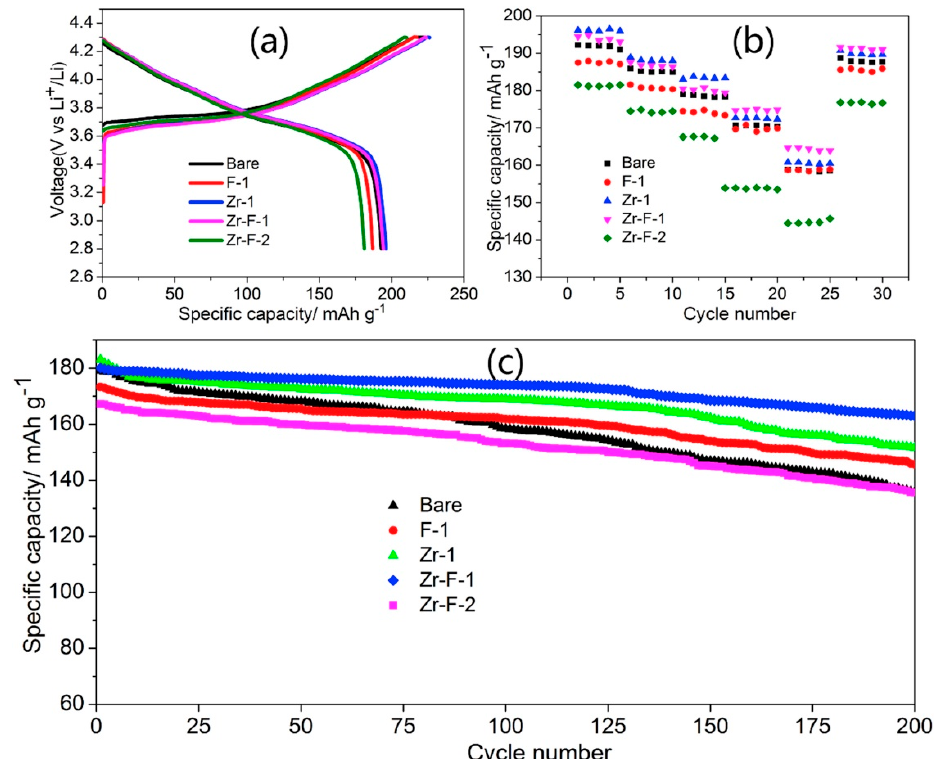
Figure 4. Electrochemical properties of Li(Ni 0.80 Co 0.15 Al 0.05 ) 1 − x Zr x O 2-y F y ( x = 0, y = 0.01, labeled F-1; x = 0.01, y = 0, labeled Zr-1; x = 0.01, y = 0.01, labeled Zr–F-1; x = 0.02, y = 0.02, labeled Zr–F-2). ( a ) Initial charge–discharge curves for all samples at 0.2 C; ( b ) rate performance at various rates and ( c ) cycling performance at 1 C. Reproduced with permission from [86]. Copyright 2019 Elsevier.